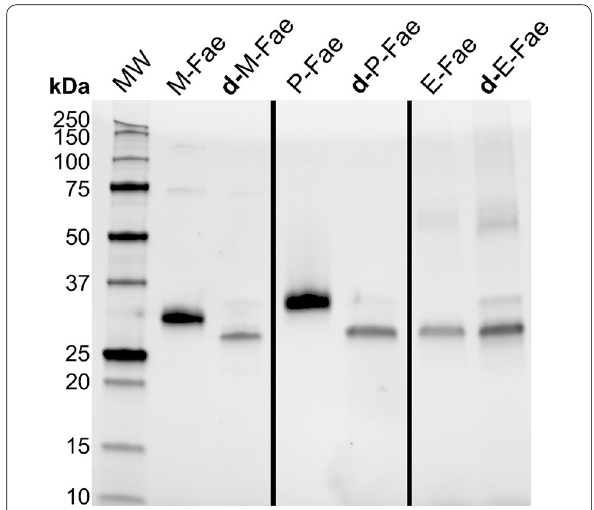
Fig. 2 SDS‑PAGE of the three purified Mt Fae1a versions before and